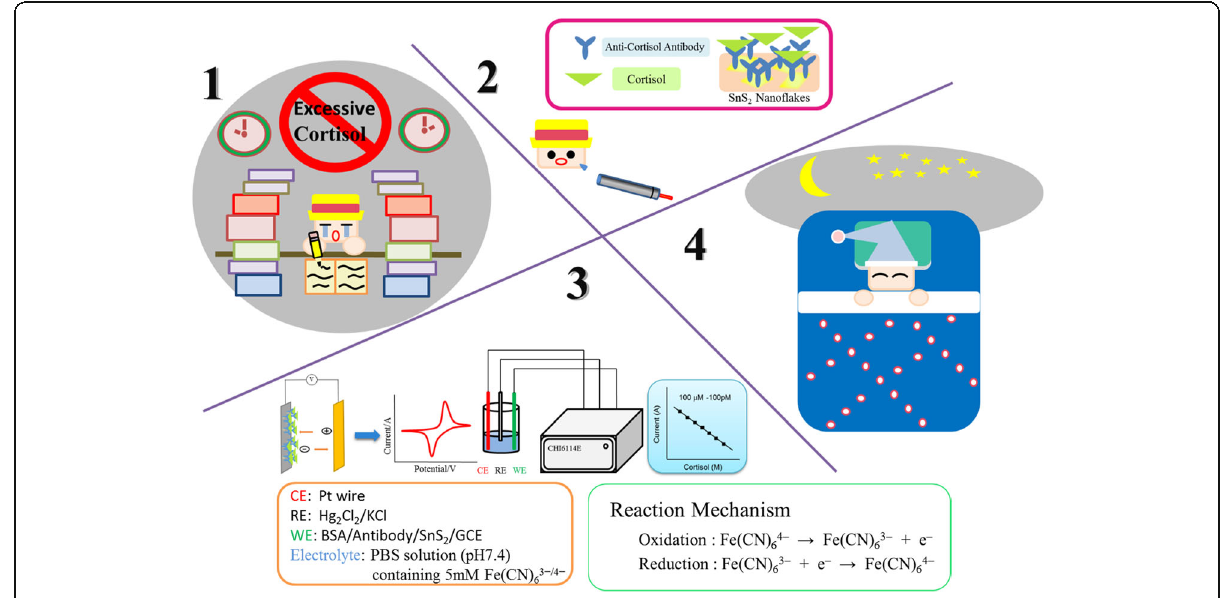
Fig. 1 Research concept and setup of the detection